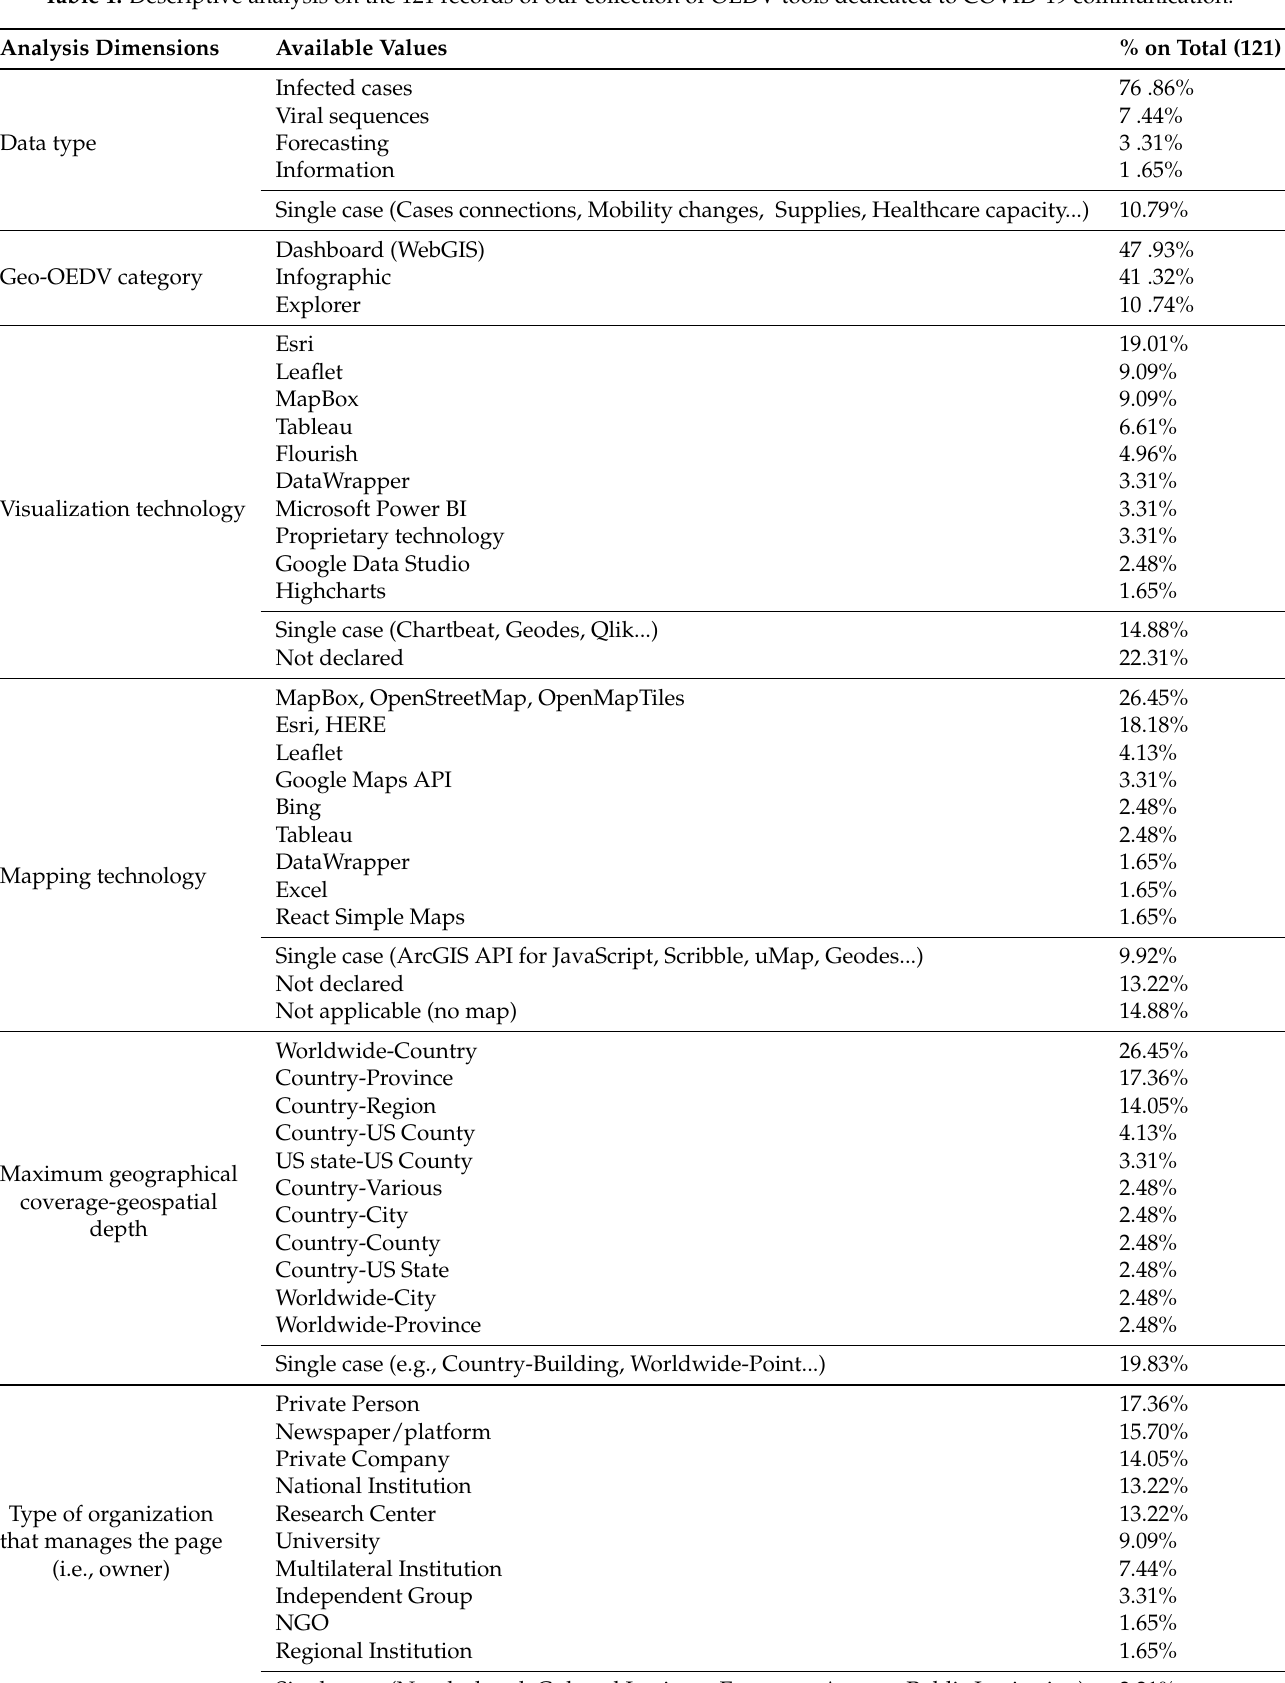
Table 1. Descriptive analysis on the 121 records of our collection of OEDV tools dedicated to COVID-19 communication. Analysis